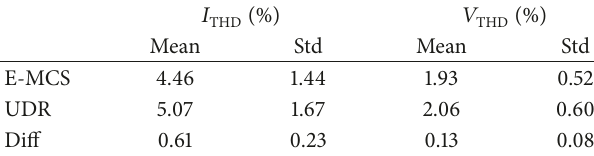
Table 3: THD result of VSCs under uniform variation of power.